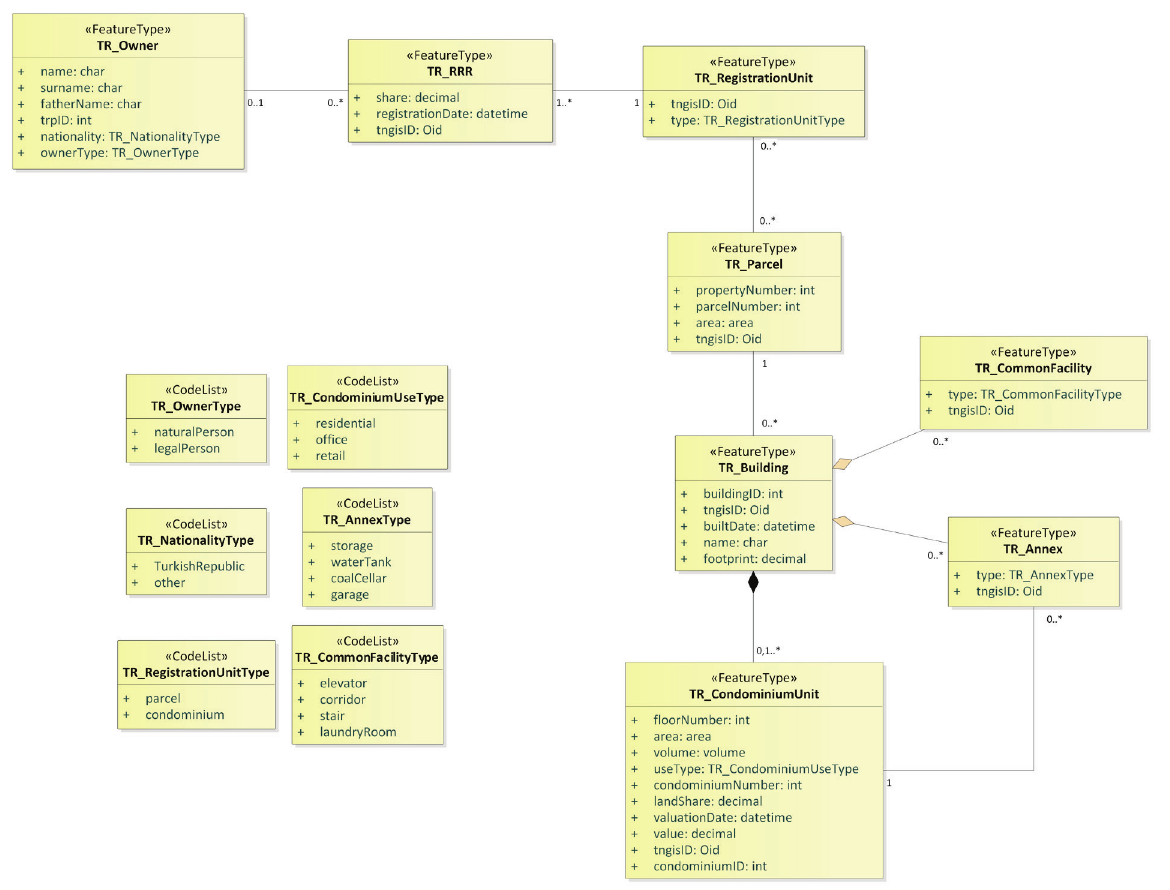
Figure 3. The conceptual model used to represent the condominium rights.